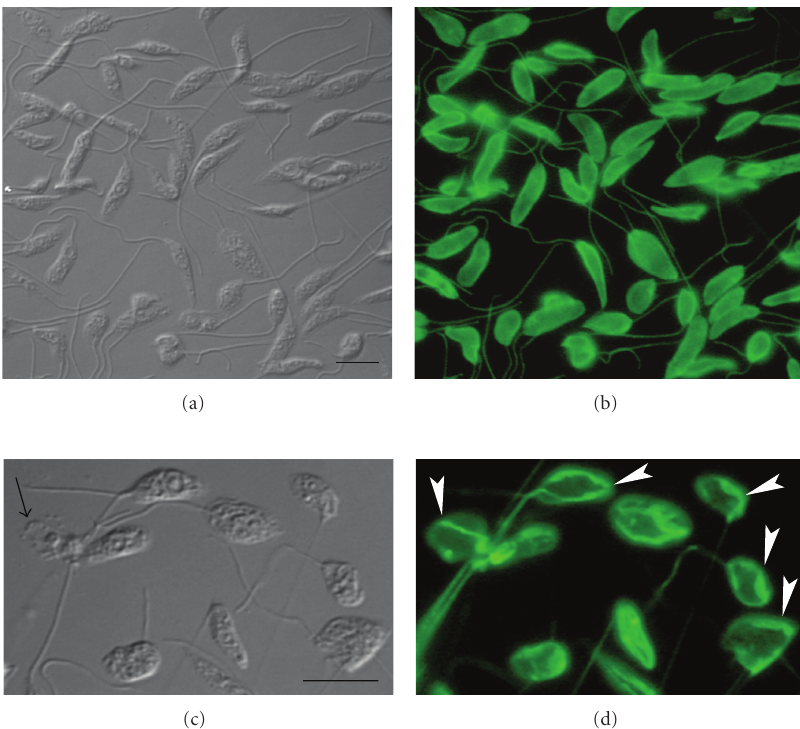
Figure 12: DIC microscopy (left panel) and immunofluorescence microcospy (right panel) of L. amazonensis promastigotes control (a)-(b) and treated with ER-119884 (c)-(d). The labeling corresponds to the cytoskeleton constituted mainly by tubulin, revelead here by using of an Alexa 488-labeled secondary antibody. The black arrow in DIC image corresponds to the cell body which sometimes appeared changed and rounded as compared to the control parasites, while the white arrows point to several tubulin clusters that accumulated in the cytosol after treatment. All images are reproduced with permission from [37] American Society for Microbiology. Bars, 5 μ